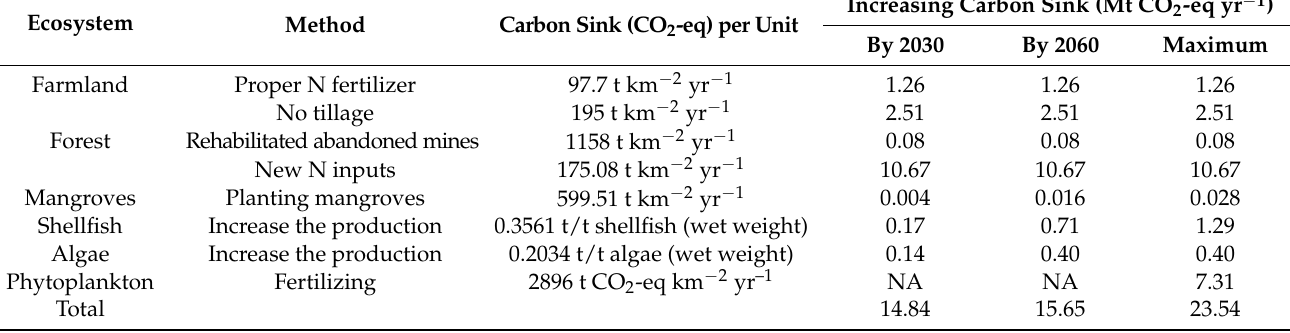
Table 2. Increased carbon sinks (accounting for CO 2